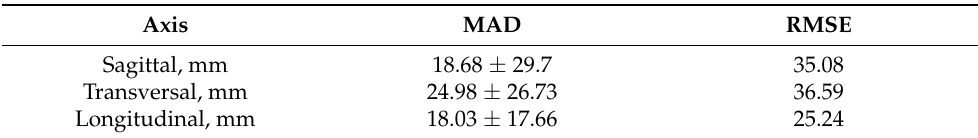
Table 3. Results for the position trajectories along the anatomical axis. Annotation: MAD = mean absolute difference, RMSE = root mean square error.